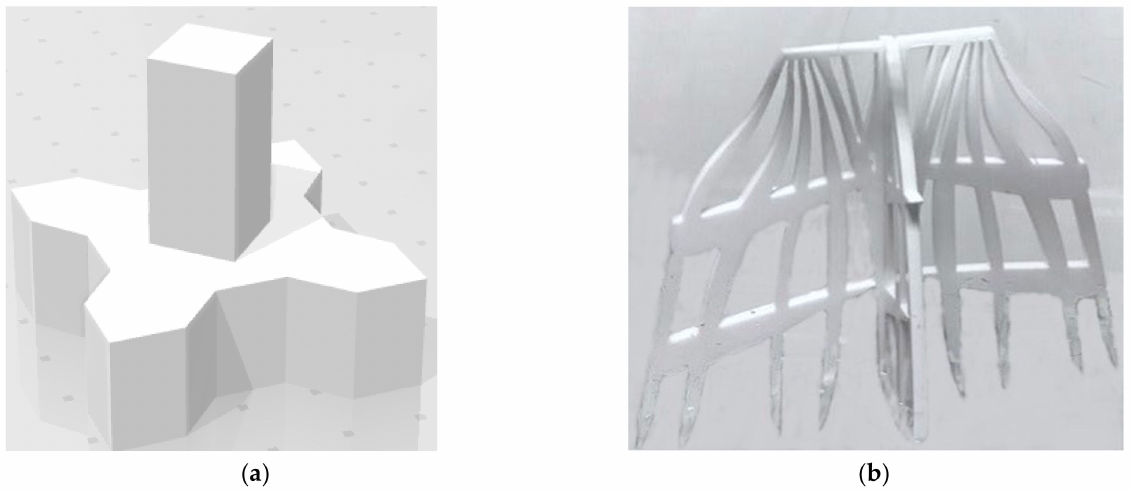
Figure 1. The designs of the Xbloc ( a ) and mangrove roots ( b ) to be 3D printed.